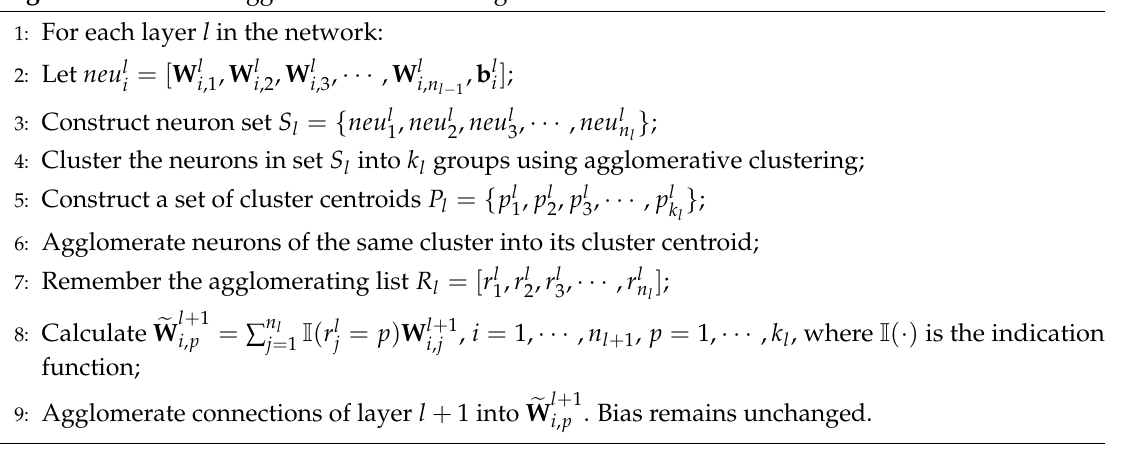
Algorithm 1 Neuron agglomerative